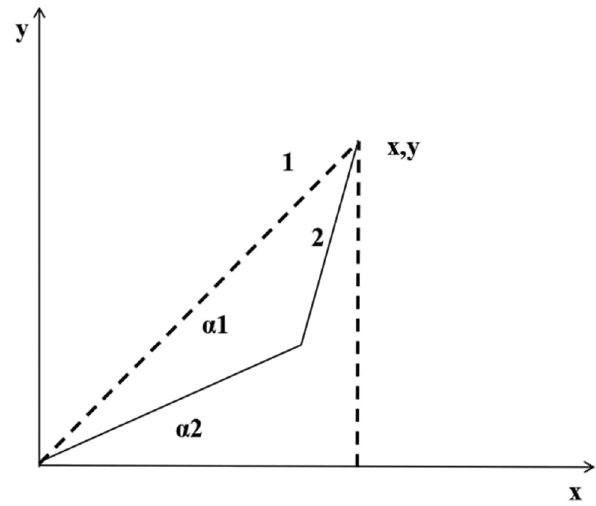
Figure 2: Schematic diagram of coordinate conversion.